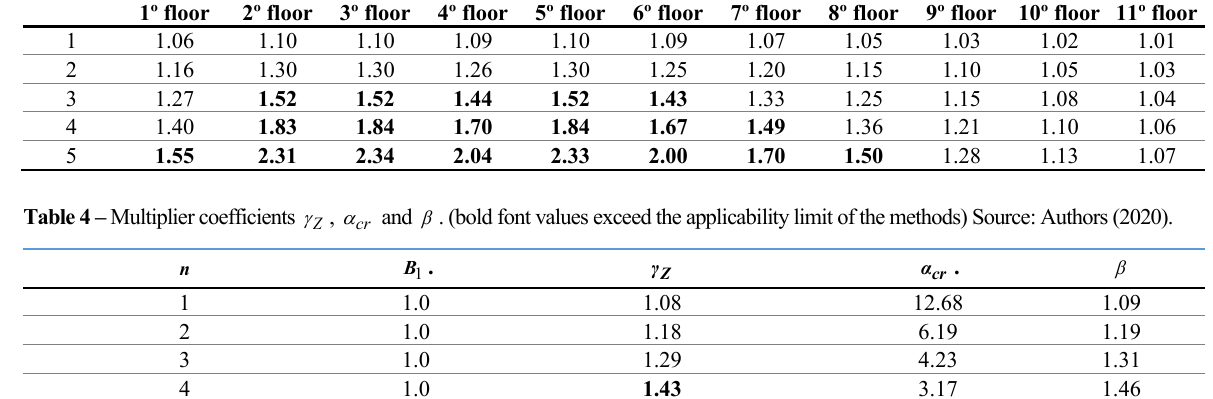
Table 3 – Final multiplier 2 B . (bold font values exceed the applicability limit of the method). Source: Authors (2020). n